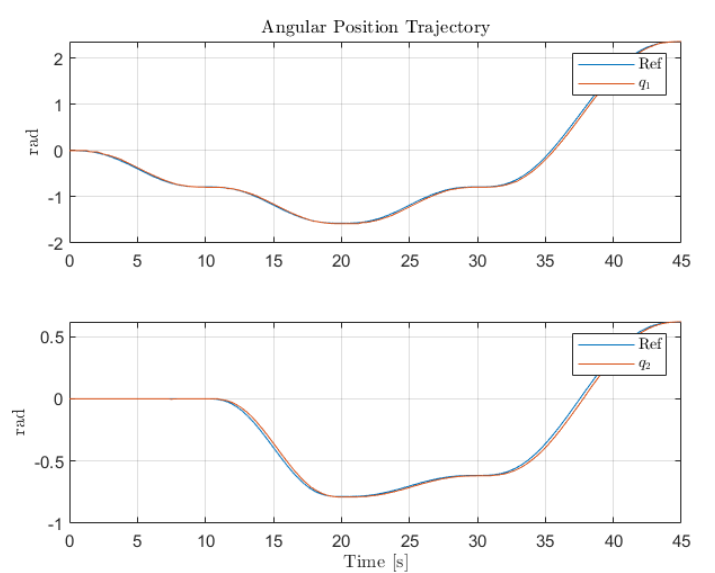
Figure 18. Individual trajectories for q i of Links 1 and 2.